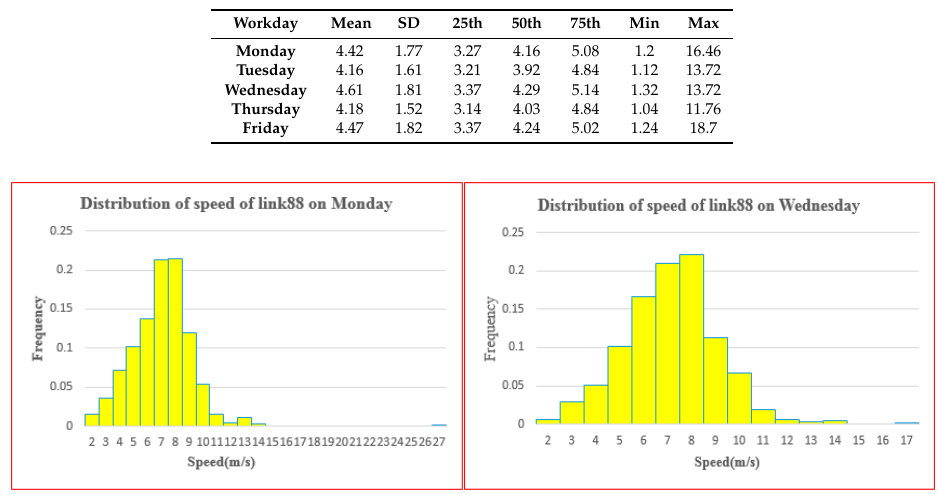
Figure 6. Distribution of speeds among the observations of link 88 on Monday and Wednesday.